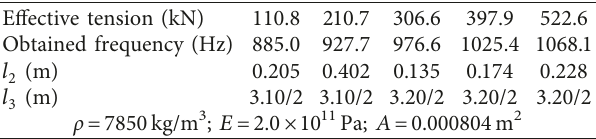
Table 1: The parameters used in the experimental model and the obtained frequencies and effective tensions.